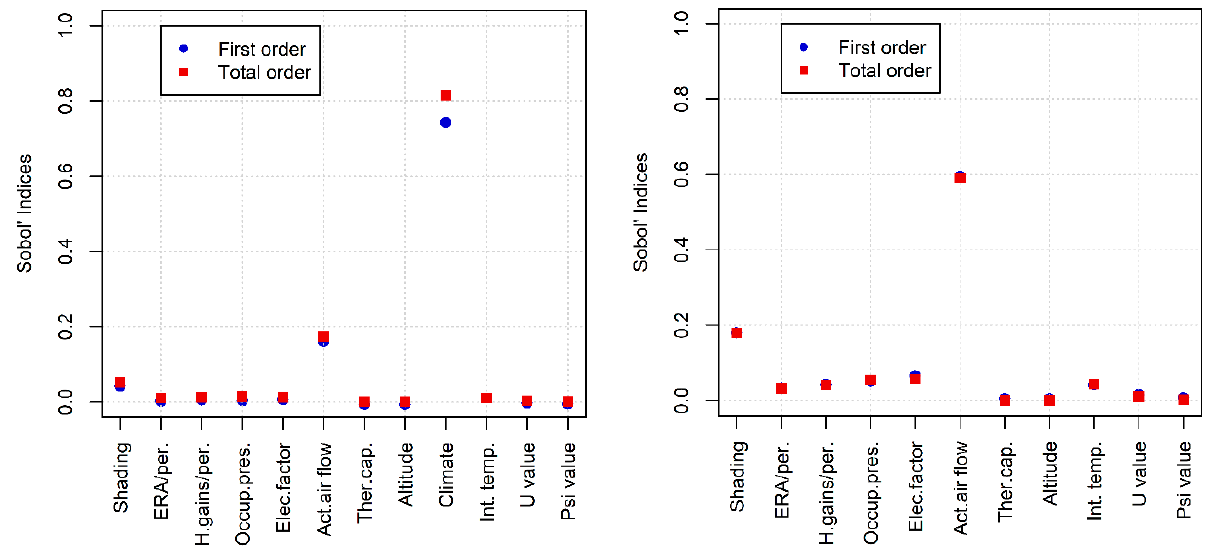
Figure 6. Sobol’ Indices for all the parameters of the model ( left ). Sobol’ Indices for all the parameters of the model, except for the climate ( right ).